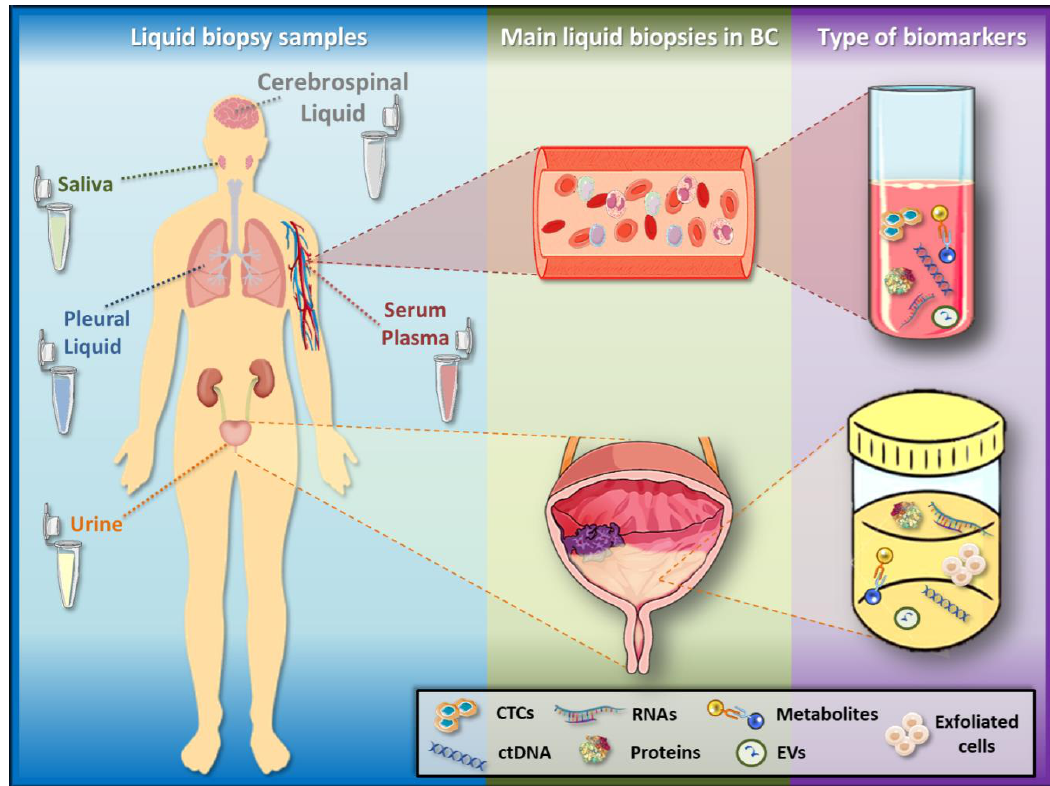
Figure 1. Liquid biopsy samples and biomarkers. Liquid biopsy samples include urine, serum, plasma, saliva, cerebrospinal and pleural fluid, among others. In BC, the liquid biopsies more widely used as detection and surveillance systems are urine (by its intimate contact with the tumour), as well as serum and plasma, which allow the follow-up of advanced disease. These liquid biopsies present several biomarkers, such as circulating tumour cells (CTCs), circulating cell-free tumour DNA (ctDNA), RNAs, proteins, metabolites and extracellular vesicles (EVs). Additionally, exfoliated cells derived from a tumour can be found in urine.